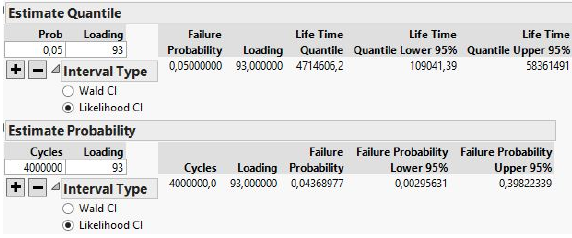
Figure 12. Custom estimate for